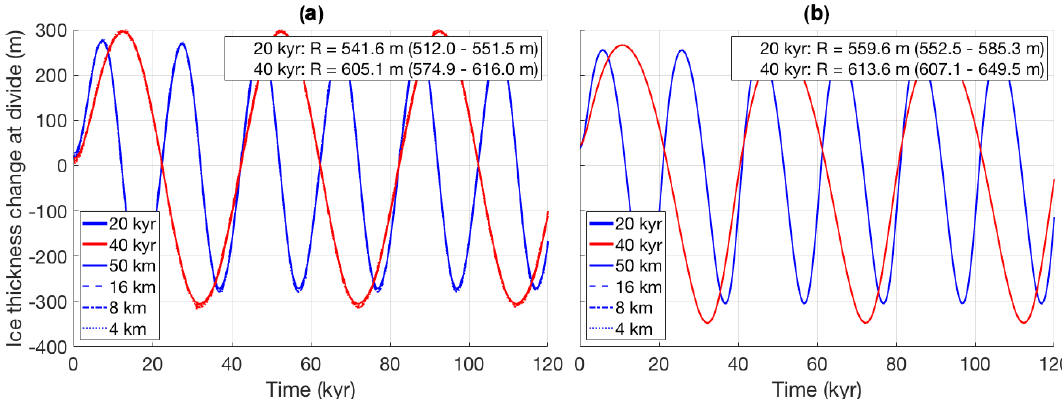
Figure 8. (a) Ice thickness change at the divide for experiments II and III (moving margin, respectively 20 (blue) and 40kyr (red) sinusoid mass balance perturbation). (b) The same for the fixed margin experiments (V and VI), simulated by UFEMISM at 50, 16, 8, and 4km ice- margin resolutions. Listed in the top-right corners of both panels are the glacial–interglacial ice thickness changes simulated by UFEMISM, compared to the ranges reported by Huybrechts et al. (1996) between brackets.